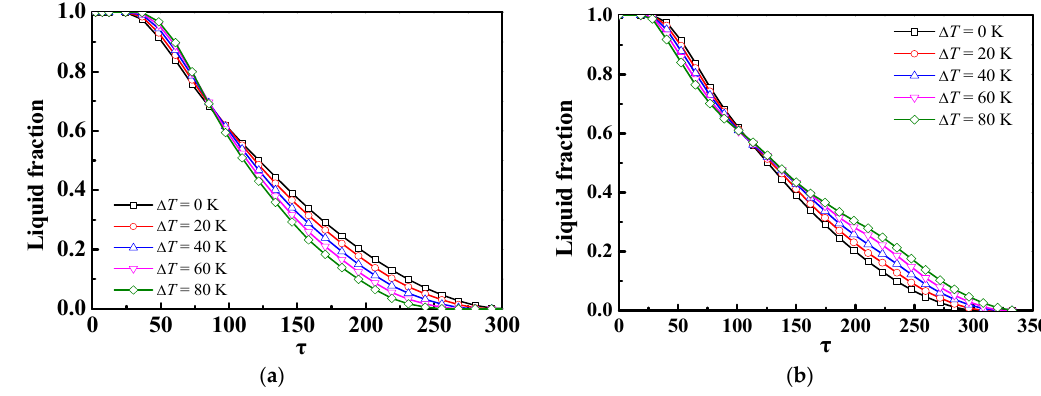
Figure 6. Dimensionless time evolution of the liquid fraction of all of the m ‐ PCMs at different Δ T . ( a ) Reversed arrangement; and ( b ) forward arrangement.